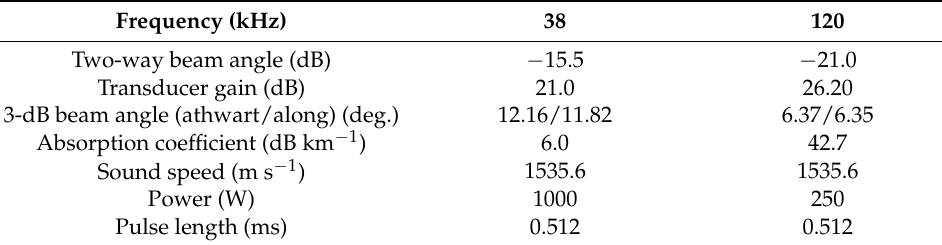
Table 1. Calibration data and parameter settings of scientific echosounder at 38 and 120